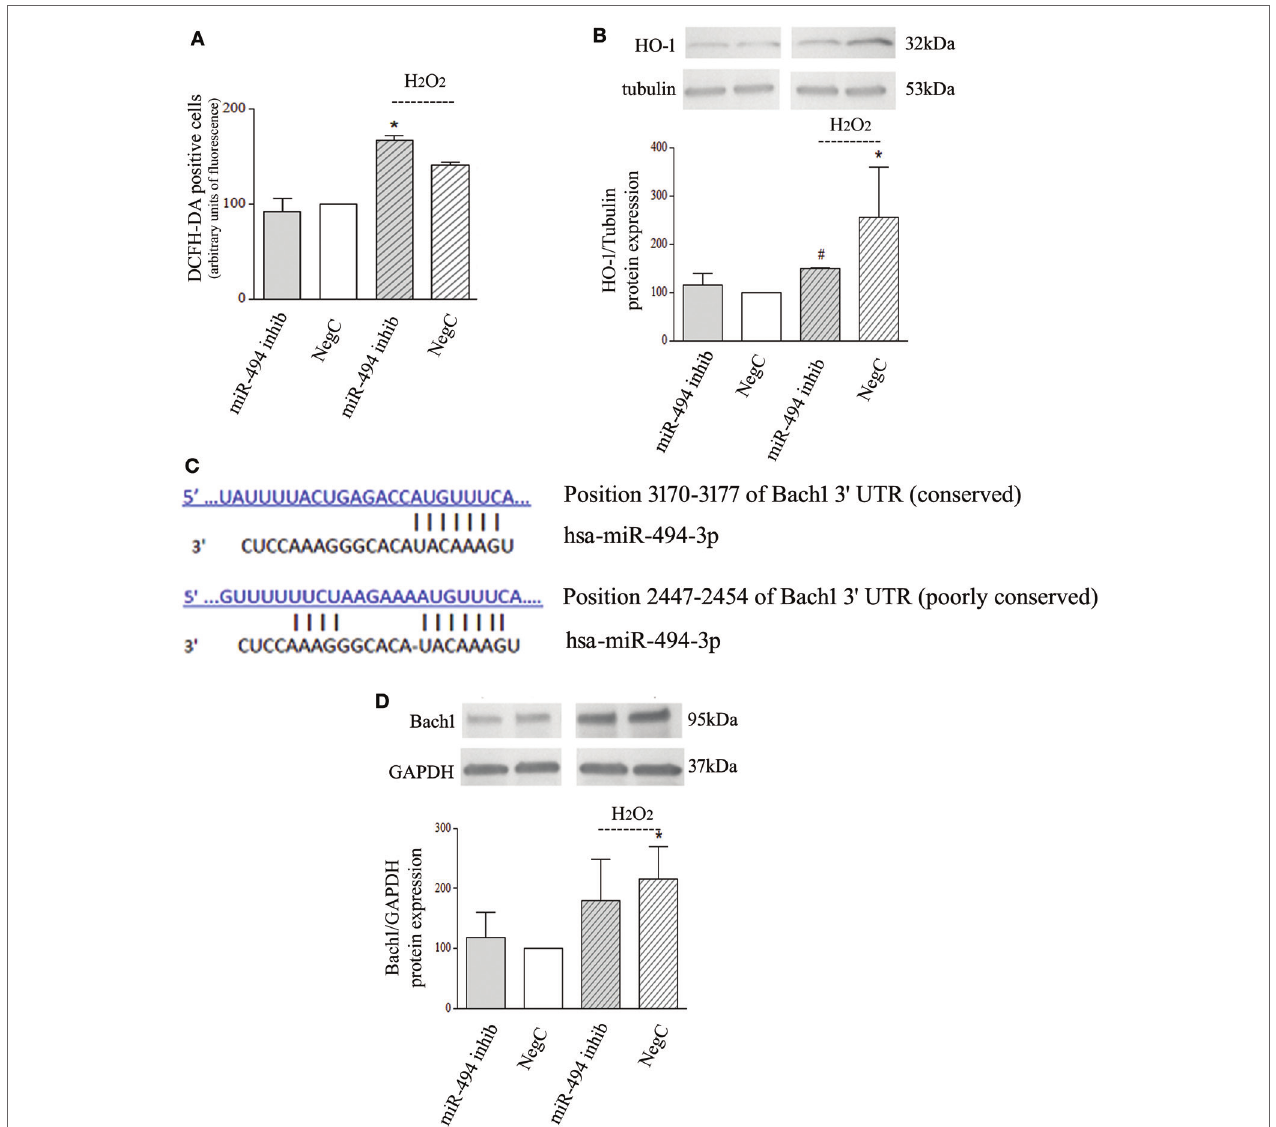
figUre 2 | miR-494 inhibition impairs heme oxygenase 1 (HO-1) induction in response to H 2 O 2 in Bach1-independent way. (a) Positivity to DCFH-DA has been measured by cytofluorimetric analyses after miR-494 inhibition and 6 h exposure to 500 µM H 2 O 2 . Statistical analysis: n = 2; * p < 0.05 vs NegC. (B) WB analysis of HO-1 expression. Tubulin expression has been used as loading control. 30 µg of protein has been loaded. The bands show the most representative experiment. Statistical analysis: n = 3; * p < 0.05 vs NegC. # p < 0.05 vs NegC + H 2 O 2 . (c) The human Bach1 3 ′ UTR contains two seed sites for miR-494. The sequence alignments were predicted using TargetScan. (D) WB analysis of Bach1 expression. GAPDH expression has been used as loading control. 30 µg of protein has been loaded. The bands show the most representative experiment. Statistical analysis: n = 4; * p < 0.05 vs